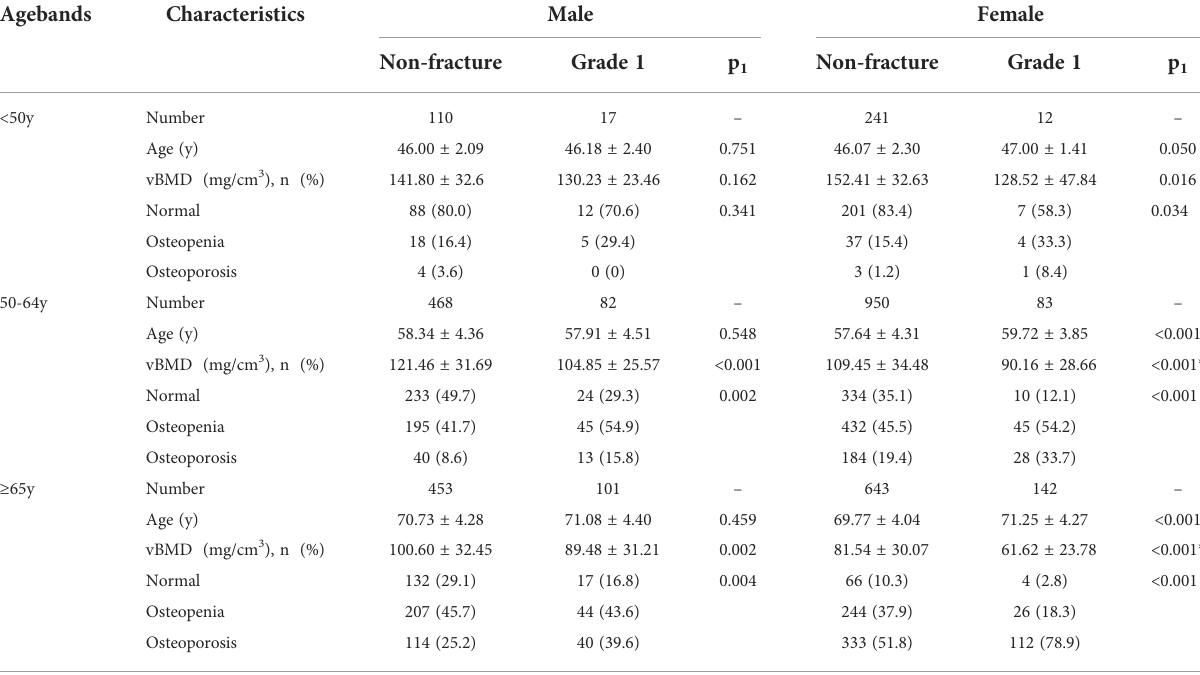
TABLE 3 Comparison of age and vBMD by gender between non-fracture group and Grade 1 vertebral fracture (VF) group in different age bands. .